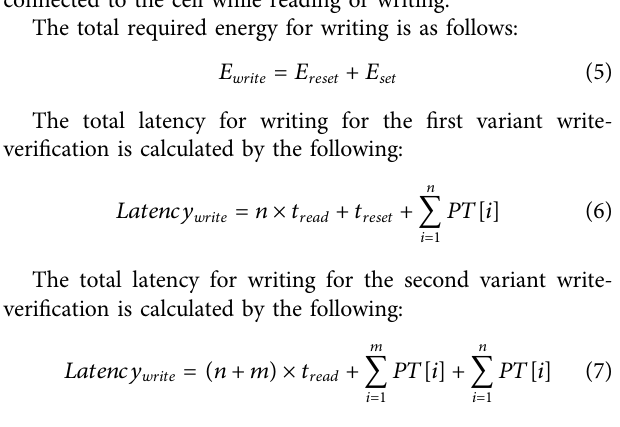
FIGURE 9 | The peripheral circuitry for SLC memory (black bordered modules) and the proposed ternary memory (red bordered modules) in parallel